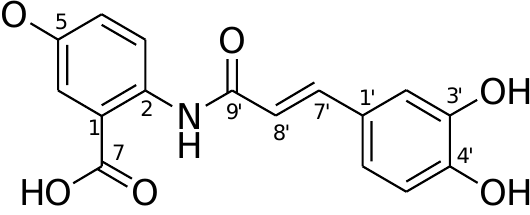
Figure 4. The chemical structure of compound 1 (Avn-C) isolated from germinated oats.